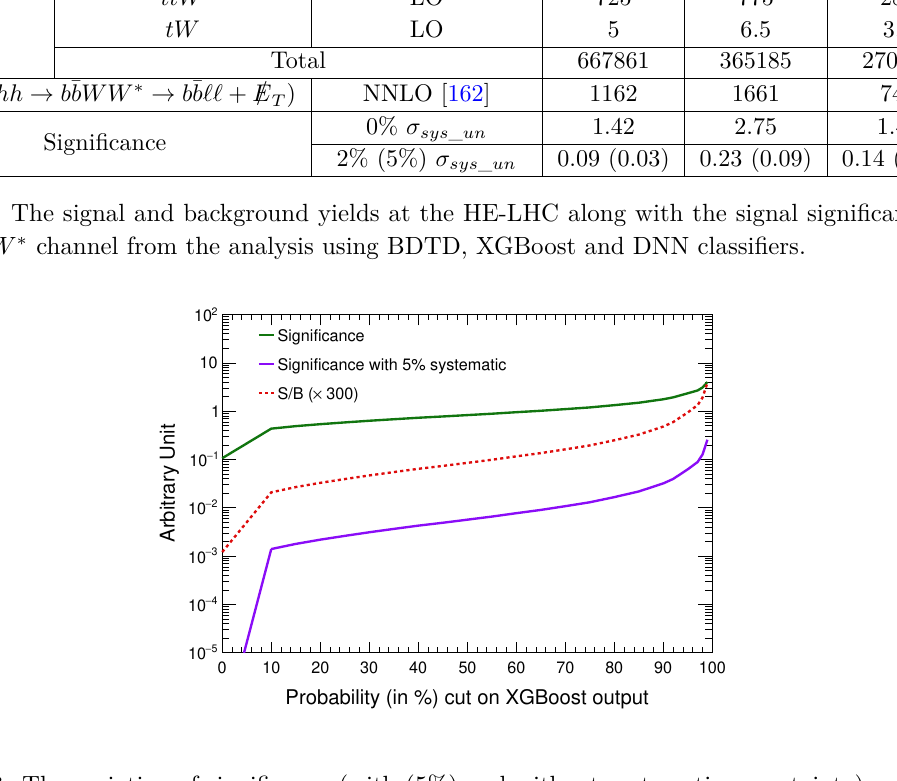
Figure 6 . The variation of significance (with ( 5% ) and without systematic uncertainty) and S/B is shown as a function of the probability cut on the XGBoost output for the b ¯ bWW ∗ final